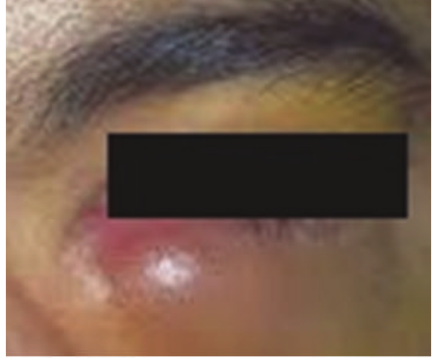
Figure 3: Histopathology: the connective tissue capsule (C) and larva within the cyst cavity surrounded by the double layered mem- brane (D). The duct-like invagination, lined by the homogeneous membrane (M) and scolex (S) (haematoxylin and eosin × 10).